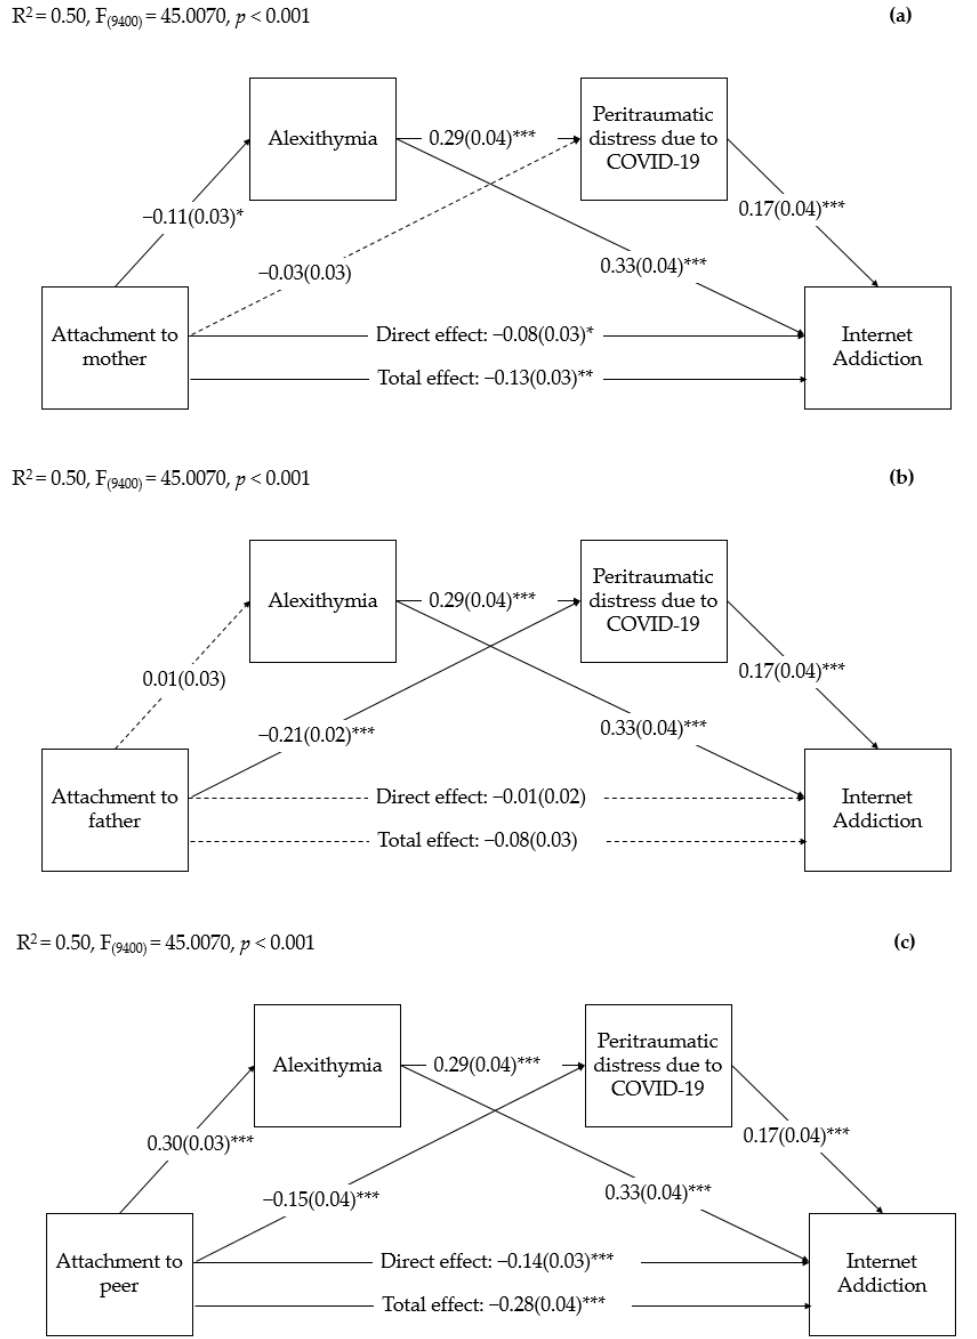
Figure 1. Serial mediation of young adult university students’ alexithymia and peritraumatic distress due to COVID-19 on the relationship between attachment to mothers and Internet Addiction ( a ), attachment to fathers and Internet Addiction ( b ), and attachment to peers and Internet Addiction ( c ). Coefficients shown are standardized path coefficients. Dotted lines represent non-significant parameters. * p < 0.05, ** p < 0.01, *** p < 0.001.